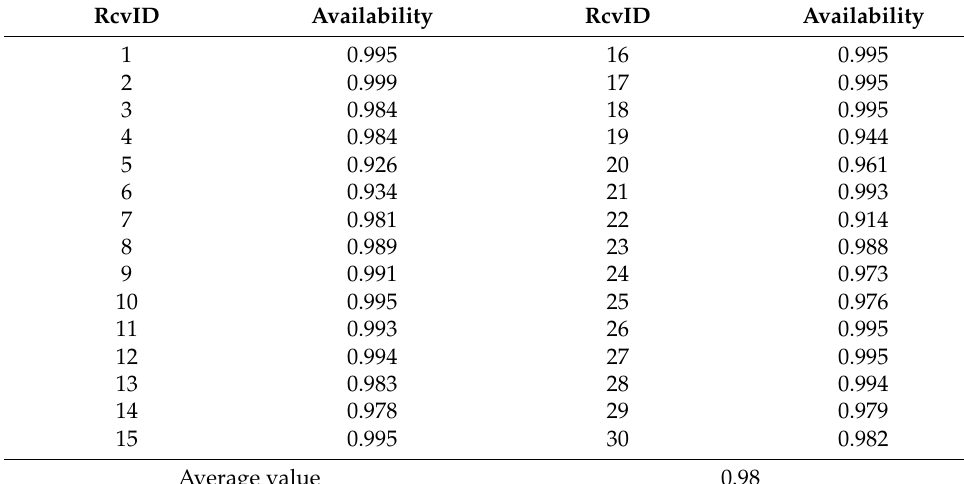
Table 4. Statistics results of monitoring receiver service